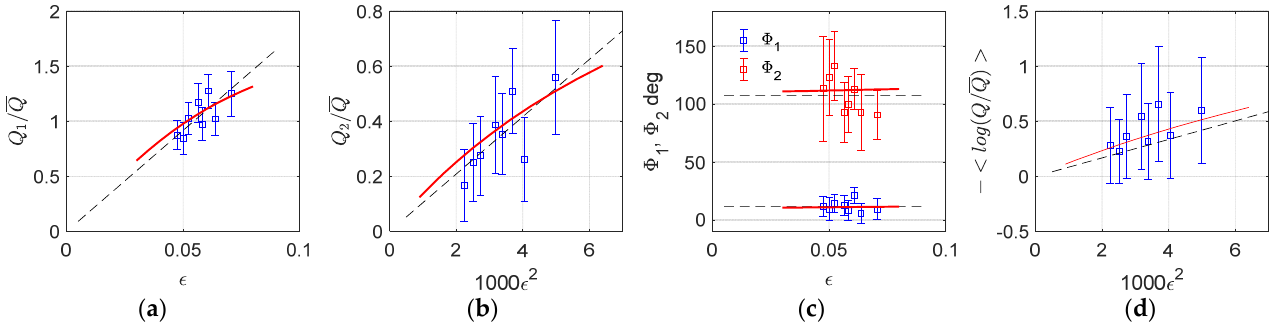
Figure A1. Normalized amplitudes ( a , b ) and phase shifts ( c ) of the first two harmonics in (A1) as a Figure A2a–c and curve 84 ε 2 ( d ). Red lines show model calculations for mean data characteristics U = 14.8 m/s and α =